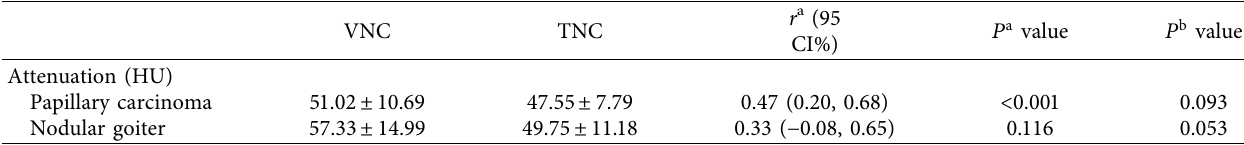
Figure 2: Tyroid CT images from a patient with papillary thyroid carcinoma. Compared with true noncontrast (TNC) images (a), virtual noncontrast (VNC) images (b) had a clear boundary of thyroid lesions. In displaying calcifcation, necrosis, and lymph node metastasis, VNC images (b and e) were consistent with TNC images (a and d). Tere was no enhancement of necrosis in the contrast-enhanced images (c and f). Table 3: Quantitative analysis of the attenuation of thyroid lesions between VNC and TNC